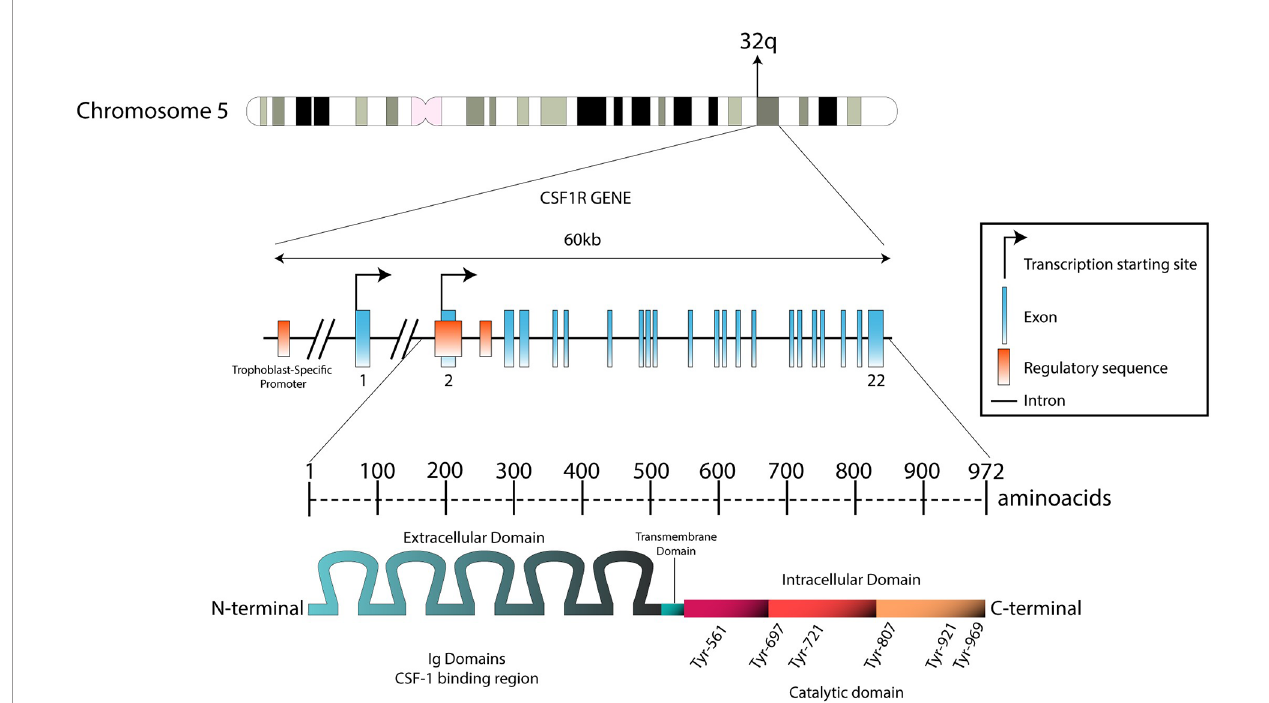
FIGURE 1 | Genomic structure of the CSF1R locus in human and protein structure. The CSF1R locus is located at the distal end of the q arm in chromosome 5 (5q32). With 60 kb length, CSF1R gene is composed by 22 exons. Transcription between the fi rst exon and exon 22 is exclusively regulated by a trophoblast- speci fi c promoter. In other tissues (such as macrophages), transcription takes place only between exon 2 and exon 22. The transcript produced is predicted to be 3.9 kb long. This product will translate in a 972-aminoacid protein with a molecular weight of 108 kDa. The N-terminal extracellular domain is composed by fi ve immunoglobulin domains (512 aa), which contain the ligand binding region. The hydrophobic transmembrane domain is 25 amino acids long. The intracellular domain contains the tyrosine residues that will be phosphorylated upon receptor stimulation (435